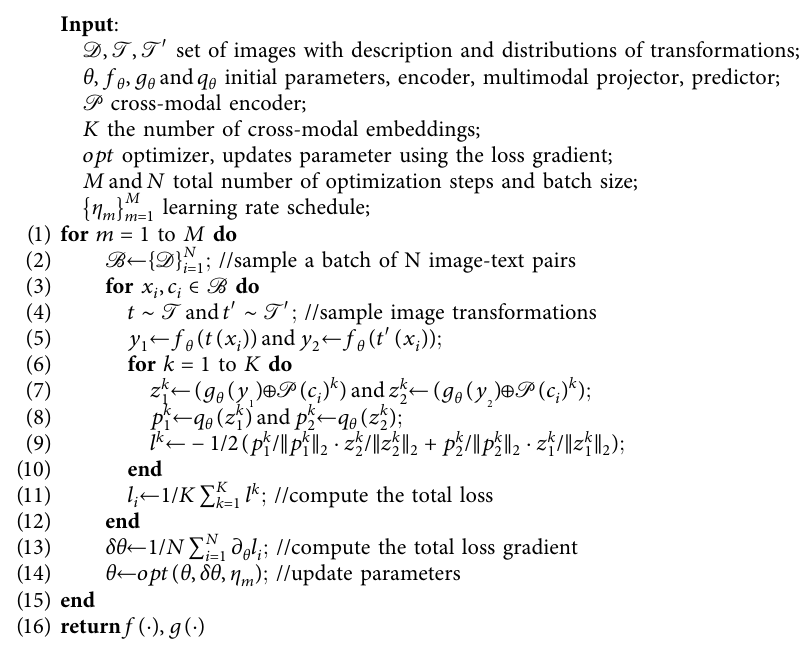
A LGORITHM 1: PTF-SimCM’s main learning